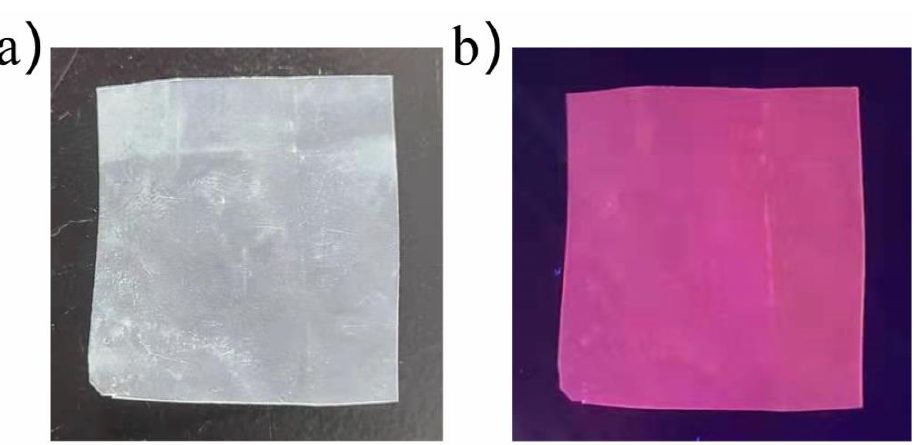
Figure 7. Photographs of the Moflight conversion material under ( a ) sunlight and ( b ) UV light. The foils measured approximately 2 × 2 cm 2